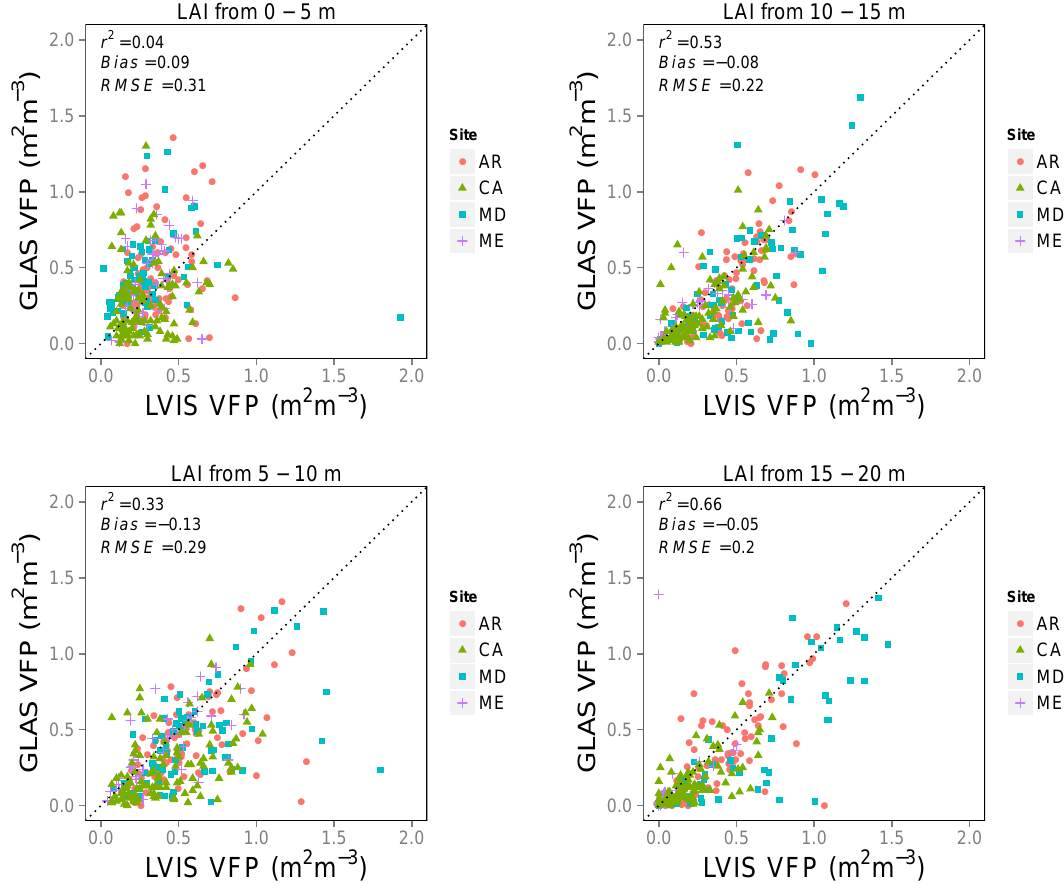
Figure 3. Comparison between LVIS and GLAS VFP density integrated at every 5m height interval (from ground to canopy top).